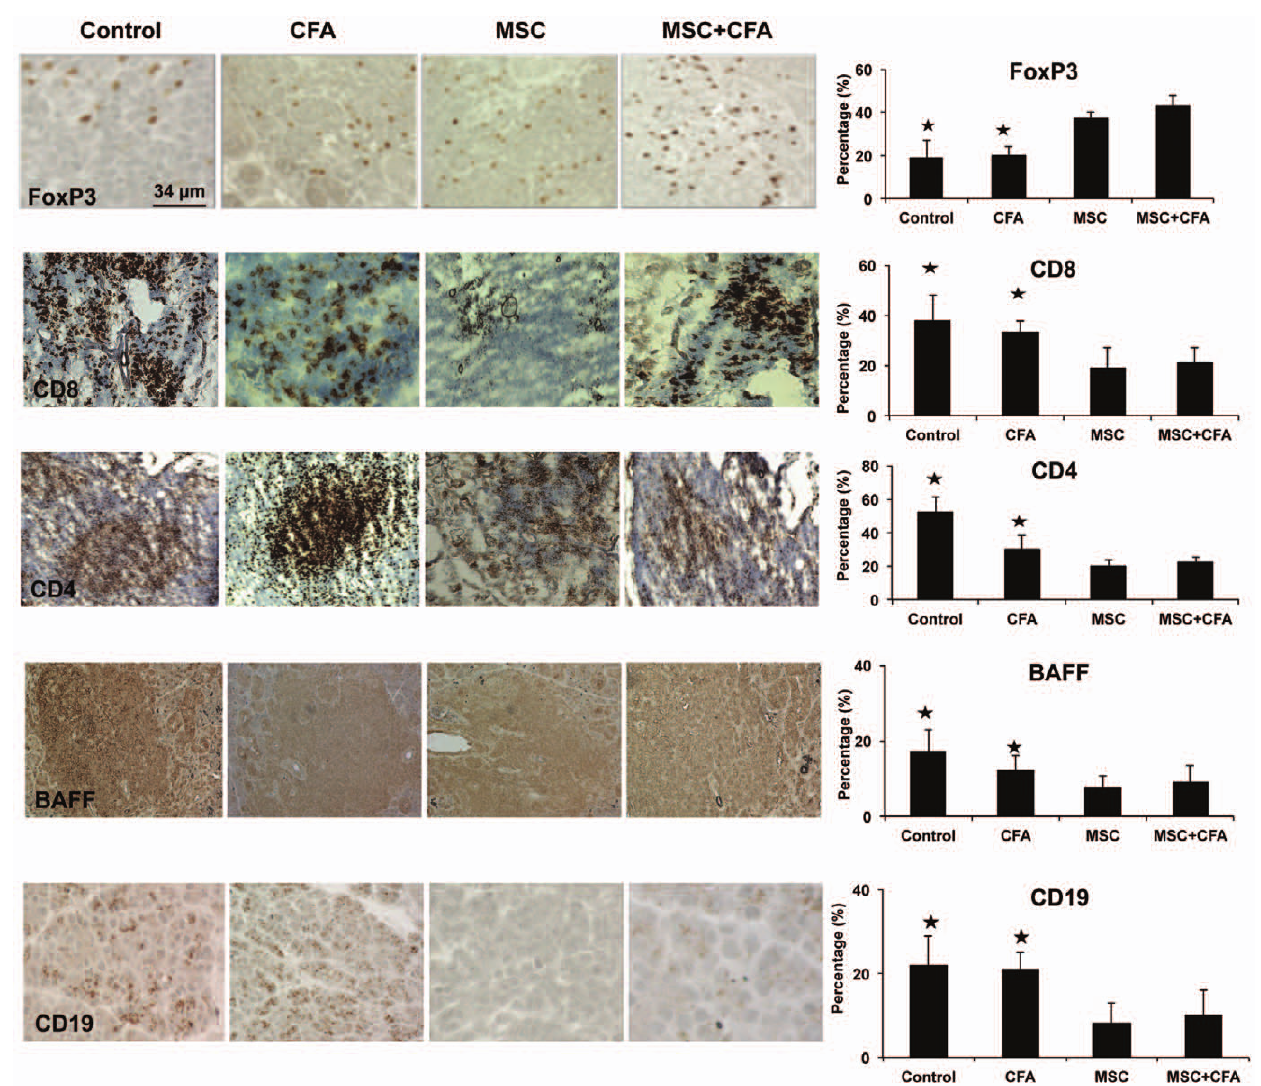
Figure 5. Immunohistochemical staining of salivary glands at week 22 (n=3 to 5 mice per group). Cells positive for Foxp3 + (regulatory T cells), CD8 + (T cytotoxic), CD4 + (T helper), BAFF and CD19 + (B cells) appeared brown in the foci. Graphs on the right represent percentage of positive cells occupying the area of the focus score. Regulatory T cells (Foxp3 + ) increased in MSC and MSC + CFA groups ( P , 0.05) while T cytotoxic (CD8 + ), T helper (CD4 + ), BAFF, and B cell (CD19 + ) decreased after MSC or MSC + CFA treatment, when compared to control and CFA groups (* P ,